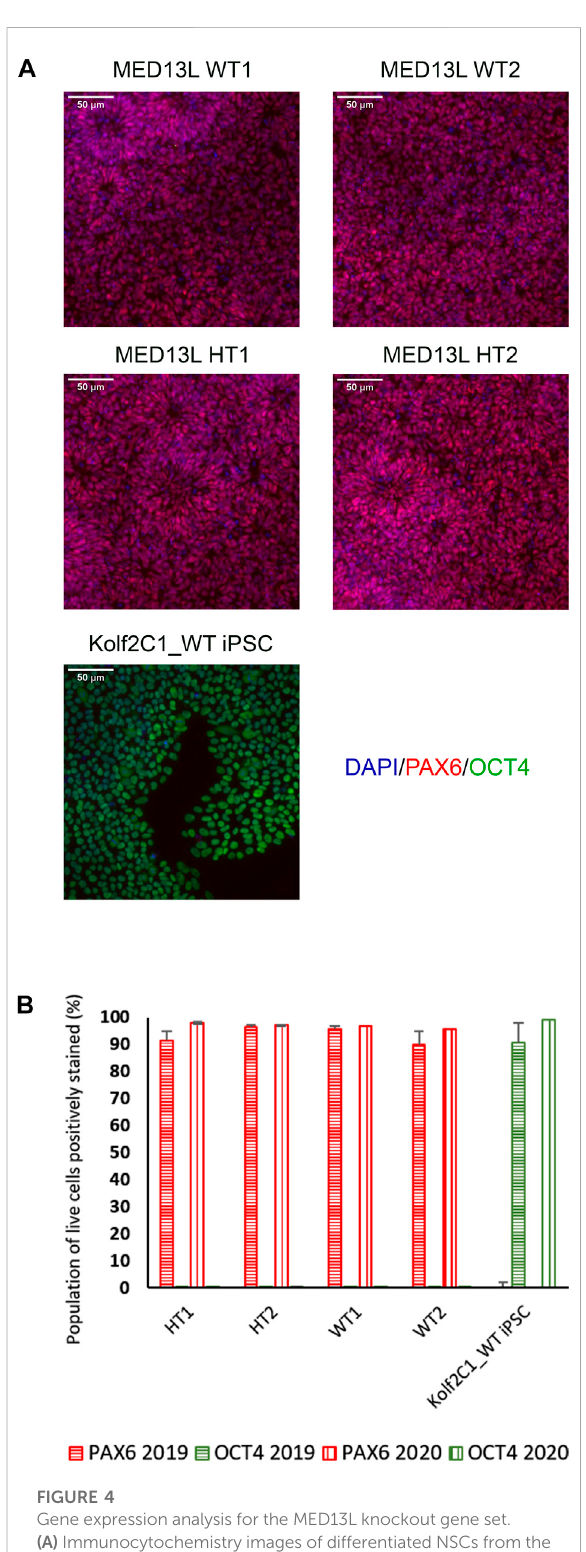
FIGURE 4 Gene expression analysis for the MED13L knockout gene set. (A) Immunocytochemistry images of differentiated NSCs from the MED13L gene set, plus Kolf2C1_WT iPSC control sample, showing expression of PAX6 and OCT4. (B) Quanti fi cation of immunocytochemistry results, comparing data from two independent rounds of differentiation (2019 and